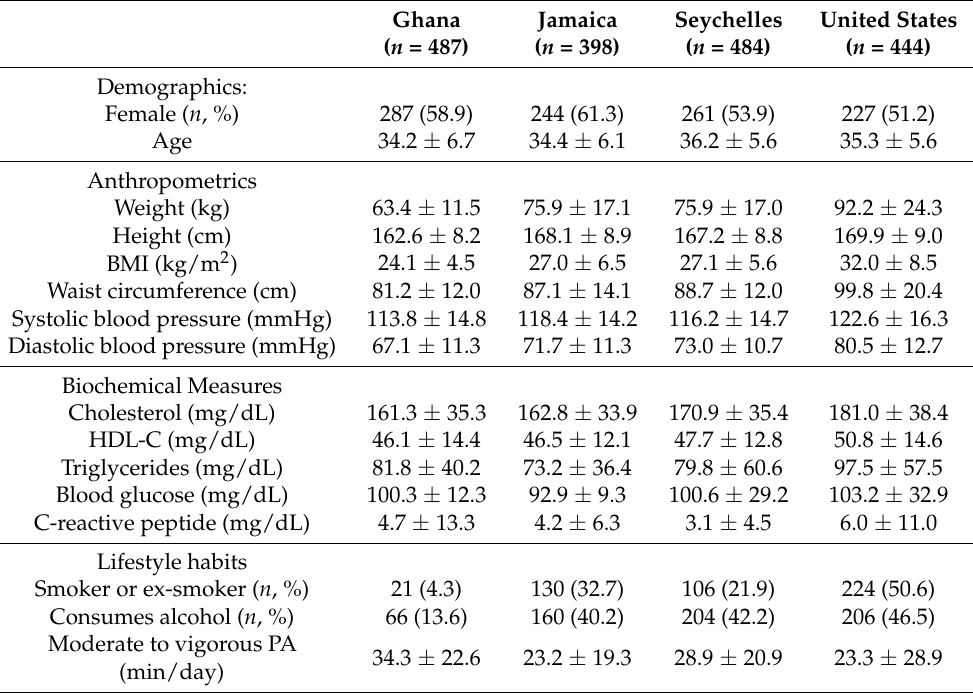
Table 1. Descriptive characteristics of study population by